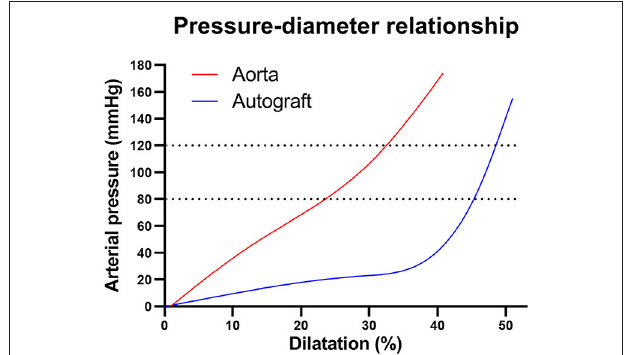
FIGURE 5 | Pressure-diameter behaviors for the healthy aortic and pulmonary root illustrating non-linear mechanical behavior. In the aortic pressure range of 80–120 mmHg (dotted lines), the pulmonary artery behaves very stiff, evident by the steep incline. Figure recreated using data available in the article by Nagy et al.